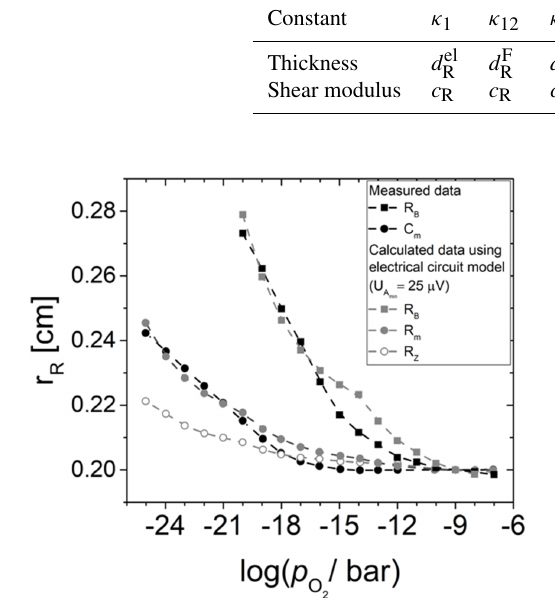
Figure 10. Resonance frequency shift (cid:49)f R in dependence of the oxygen partial pressure p O . Measured data (black) from Fritze et 2 al. (2005) are compared to calculated data using the effective elec- trode radius of the capacitance C m (blue) and the real part of the impedance in resonance R Z